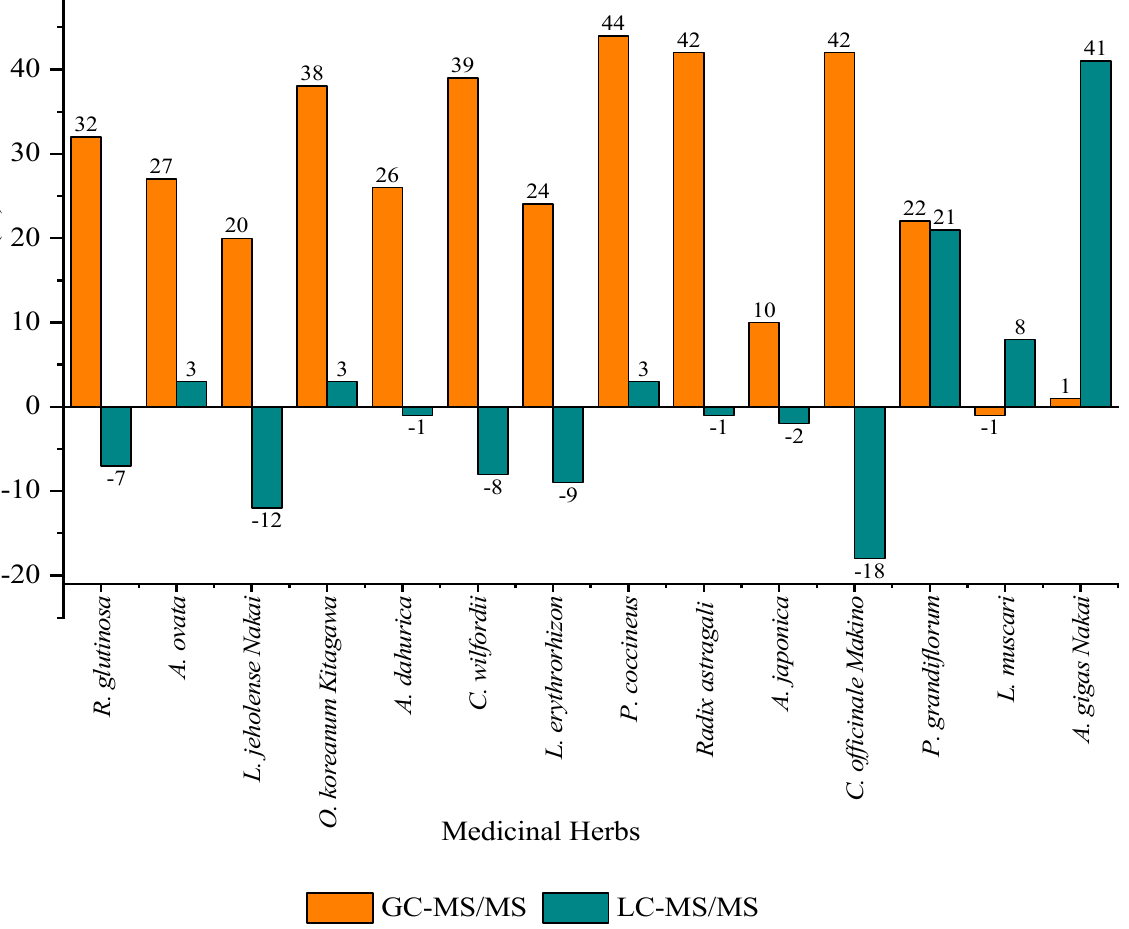
Figure 2. Matrix effect (%) of indoxacarb in 14 medicinal herbs analyzed by GC–MS/MS and LC–MS/MS.